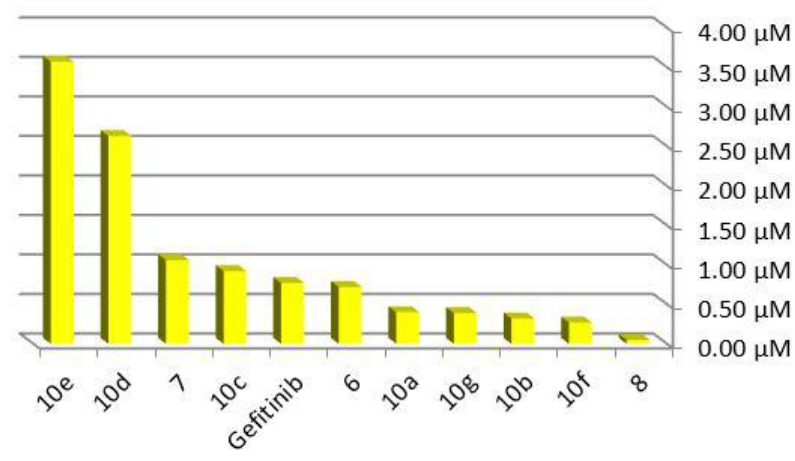
Figure 3. 1/IC 50 values for cytotoxic screening of title compounds against MDA-MBA-231 cell line sorted from the least active one ( 8 ) to the most active one ( 10e ). Compounds 10e , 10d , 7 and 10c display better activity than the reference gefitinib.